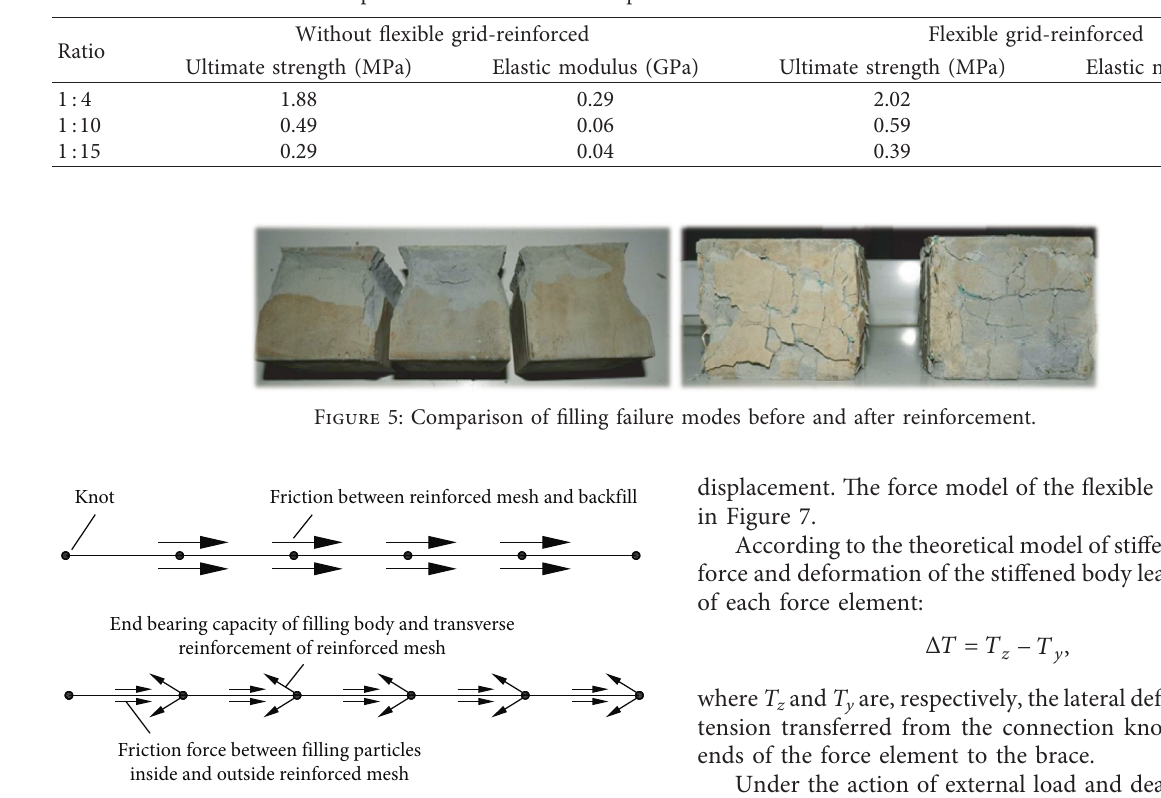
Figure 6: Coupling relationship between flexible grid and stiffener.